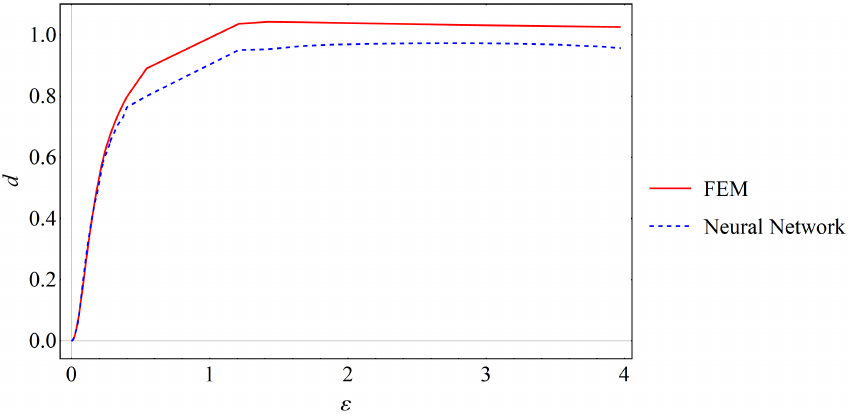
Figure 17. Case 2: V-notched tension test. Fracture phase-field d curves versus the strain ε